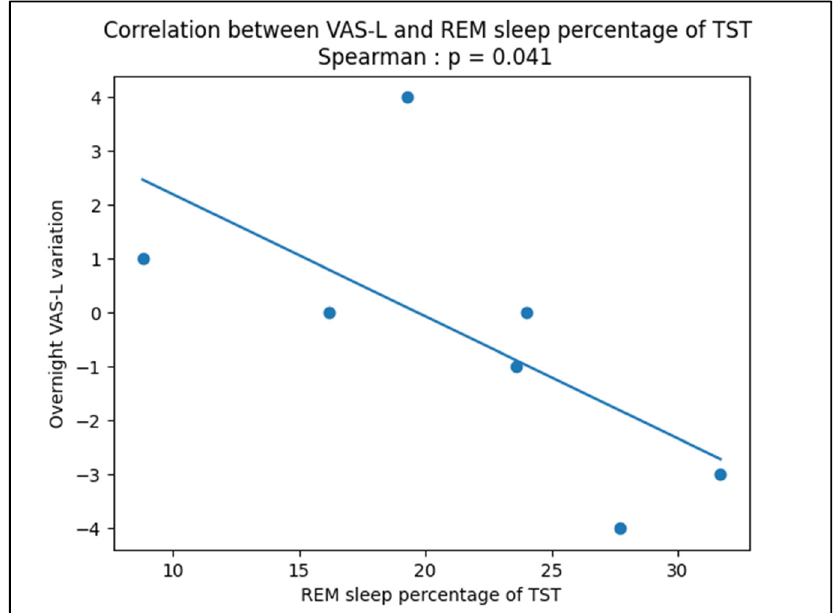
Figure A1. Anticorrelation between REM sleep percentage of total sleep time and overnight VAS-L variation, TST: total sleep time.